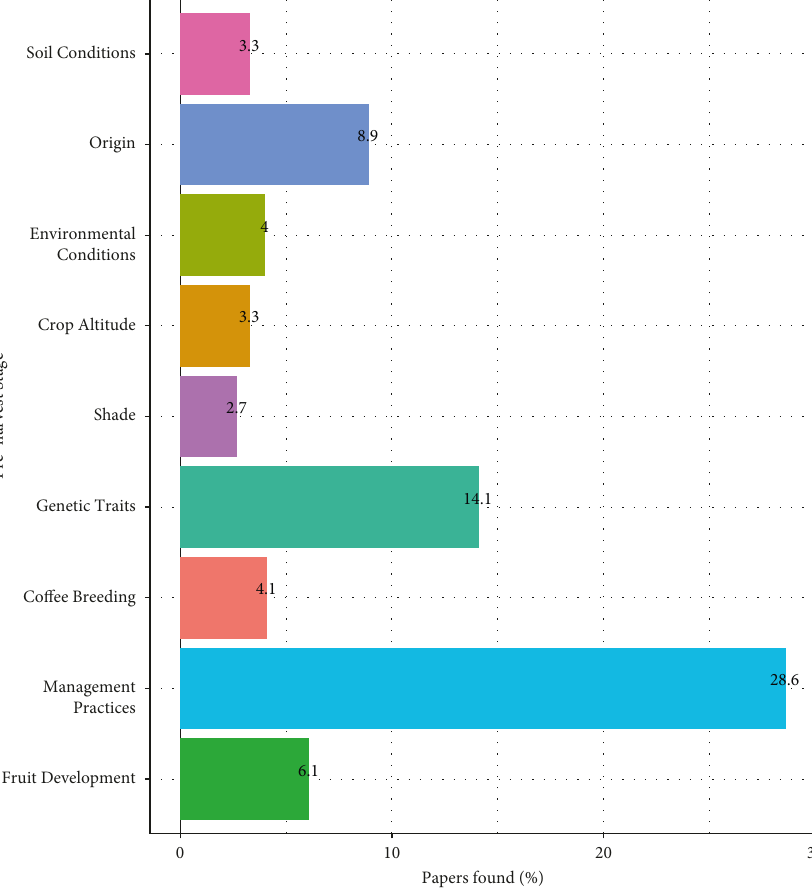
Figure 9: Percentage of the articles centered on the preharvest stage.